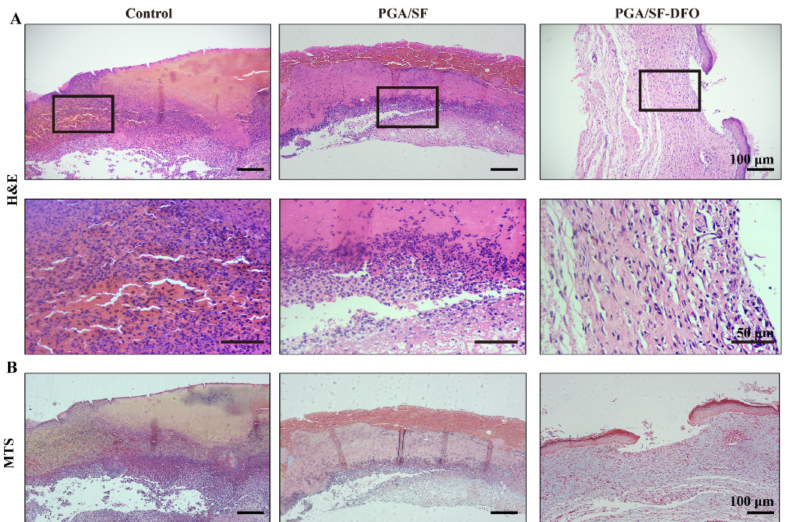
Figure 9. Histopathological analysis of the wound beds at day 7 post-implantation. ( A ) H&E staining of wound beds. ( B ) Masson’s trichrome staining of wound